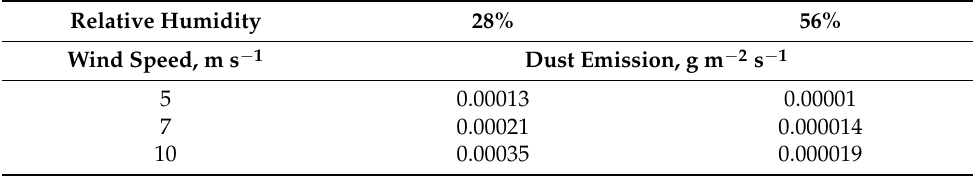
Table 3. Relative humidity and dust emission